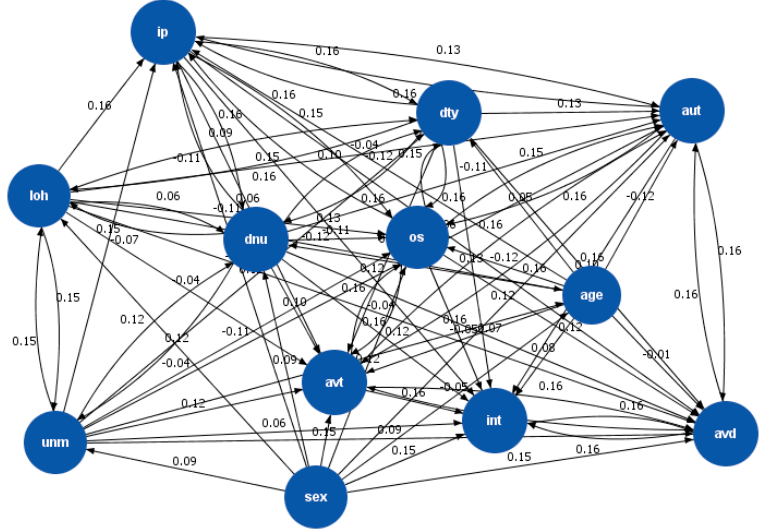
Figure 4. A depiction of the proposed FCM to ADVOCATE framework.